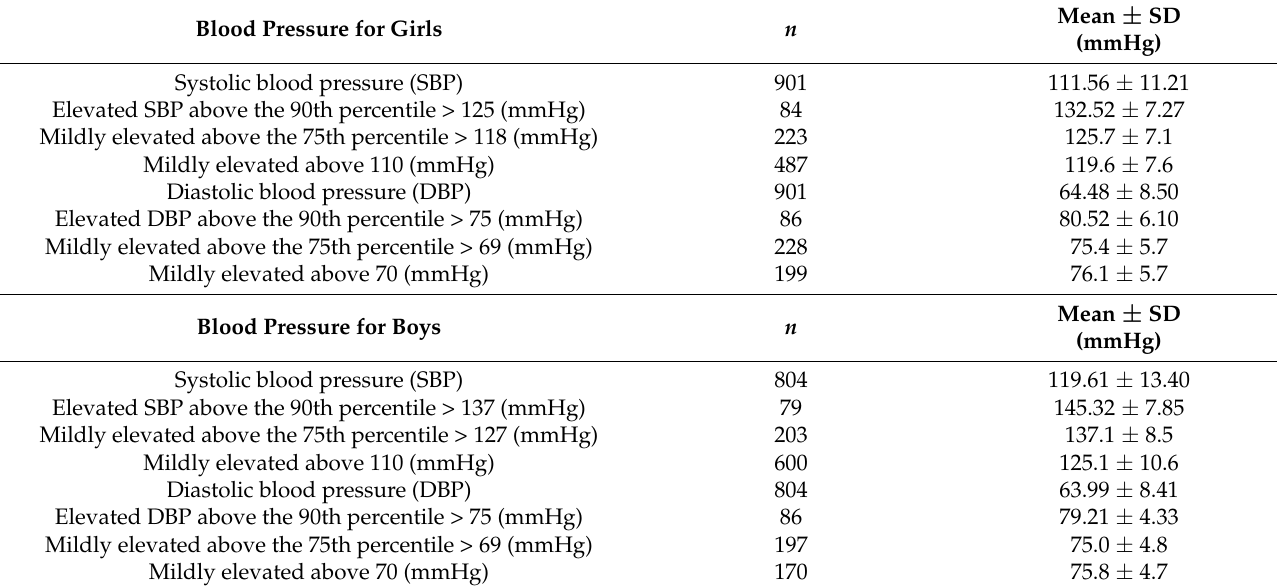
Table 3. Blood pressure data and threshold for elevated blood